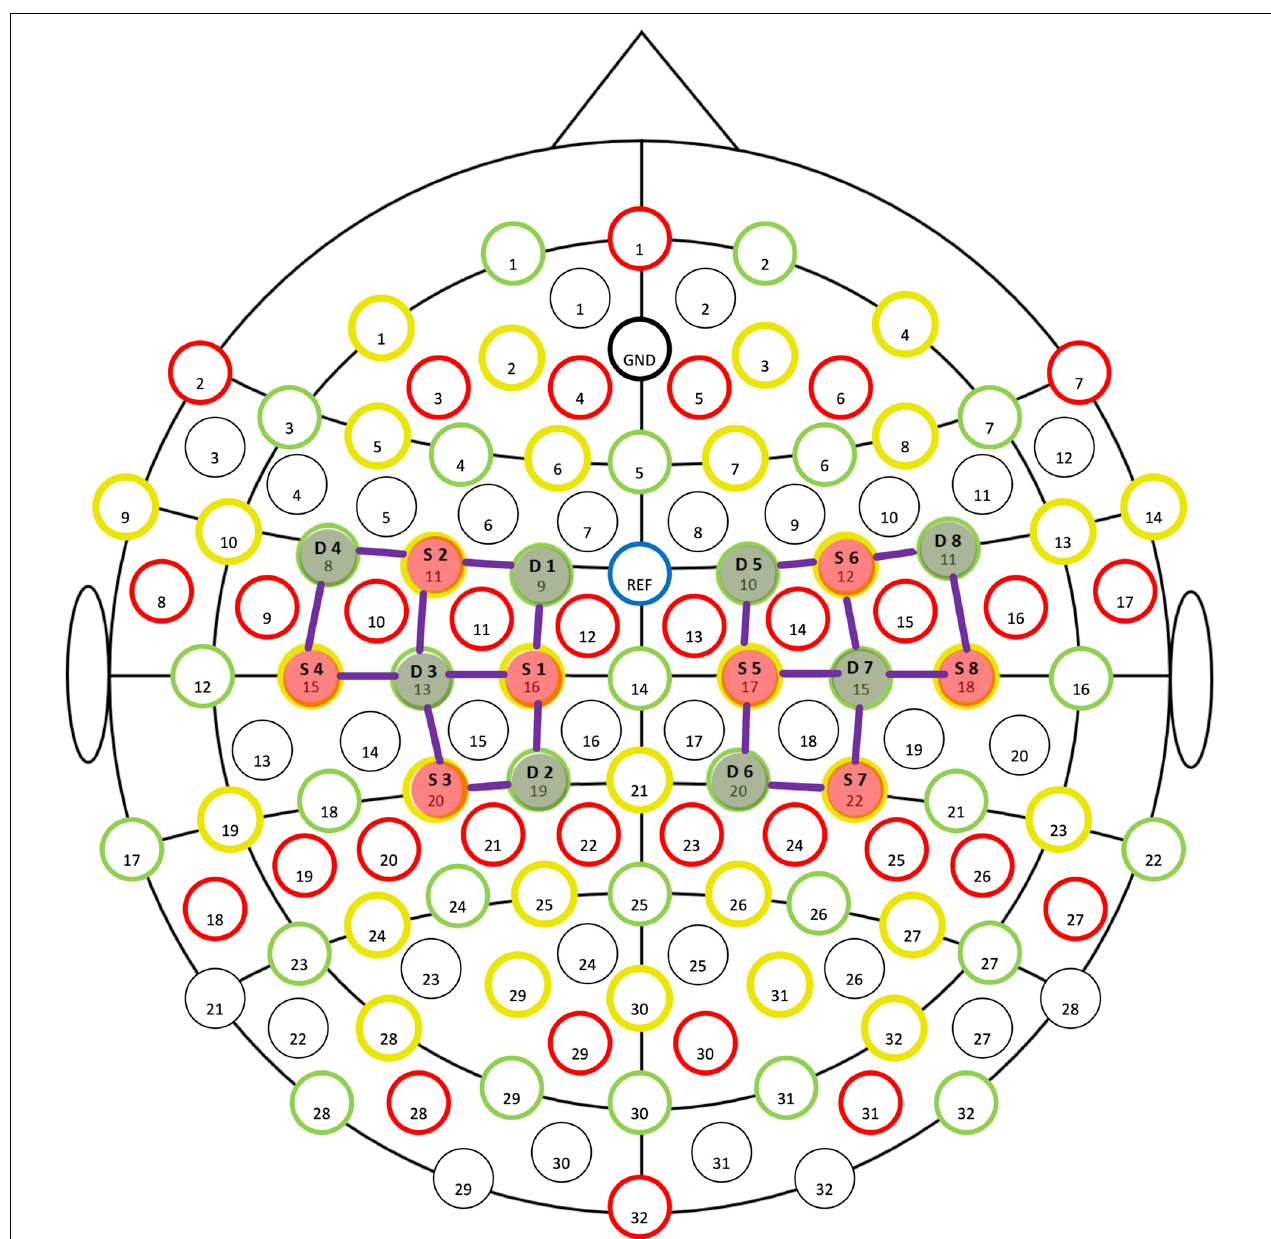
FIGURE 1 | Schematic diagram of placement at the sources (S1–S8) and detector